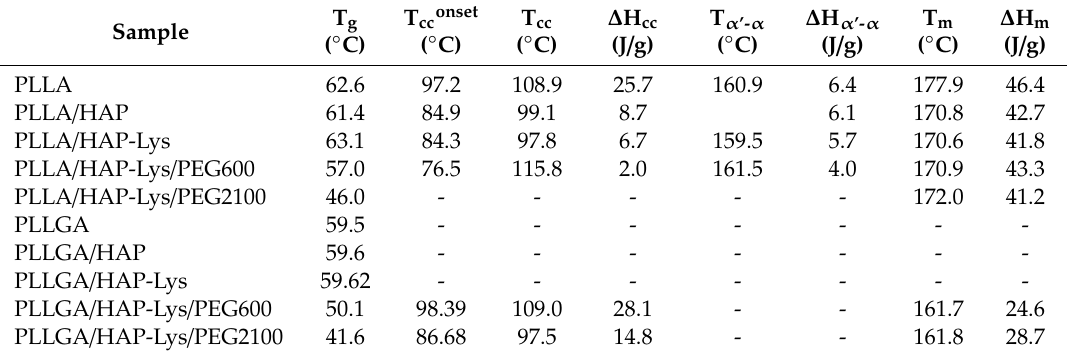
Table 3. Thermal Parameters from Second Heating DSC Curves of PLLA and PLLGA Sample